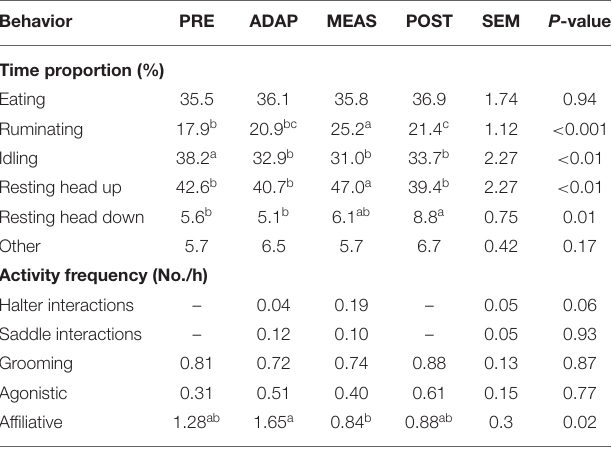
TABLE 2 | List and description of the evaluated behaviors. Behavior Description Ingestive